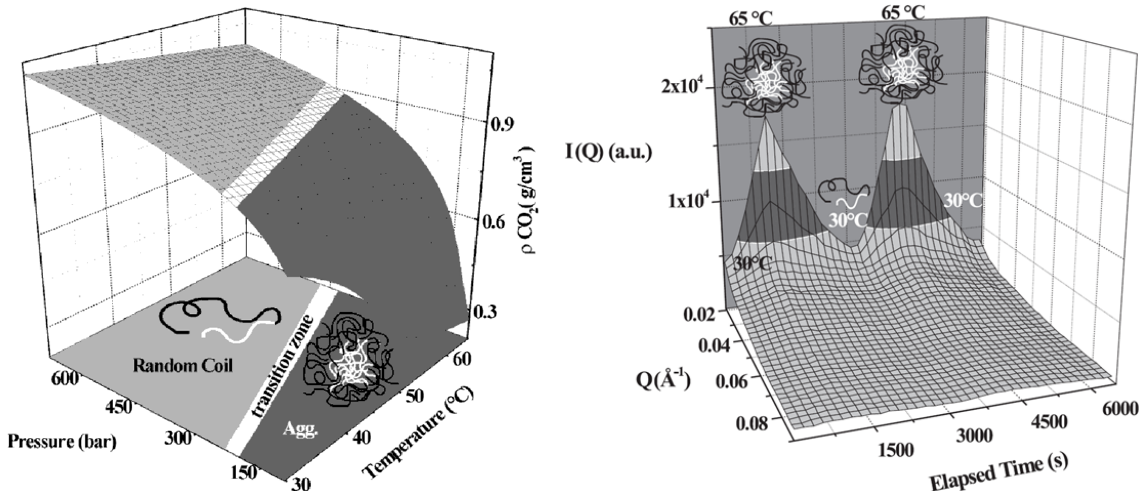
Figure 8: Left: Nano-structure (aggregates and random coils) of a the Co-Polymer (PVAc-b-PFOA) as a function of CO2 pressure, temperature and CO2 density [71]; Right: In situ scattering curves of a 7% PVAc-b-PFOA solution in CO2 at p = 250 bar at four alternate heating (up to 65 ∘ C) and cooling (down to 30 ∘ C) cycles are shown and their nanostructures depicted in the 3-D plot [68]